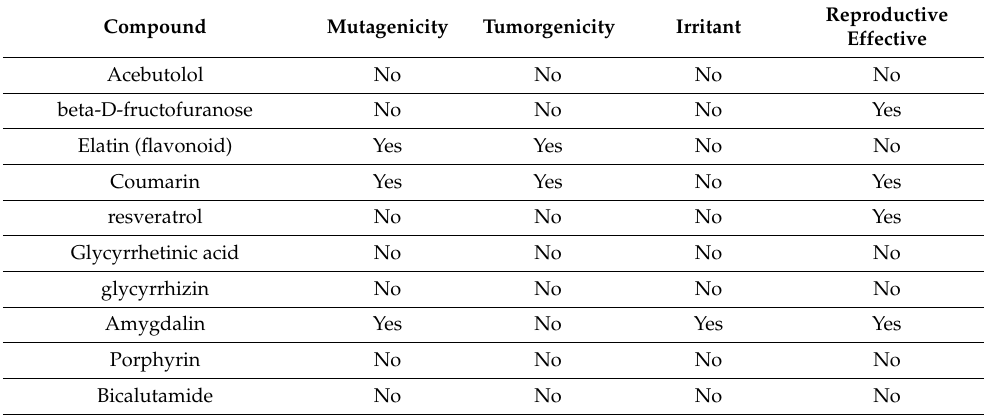
Table 5. Pathogenicity constraints predication for the identified compounds.